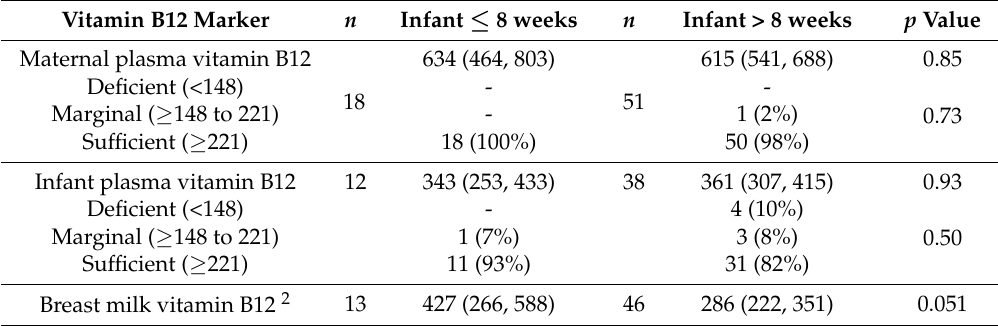
Table 4. Total vitamin B12 concentrations and prevalence of vitamin B12 sufficiency by infant age (older or younger than 8 weeks) among the Cambodian sample 1